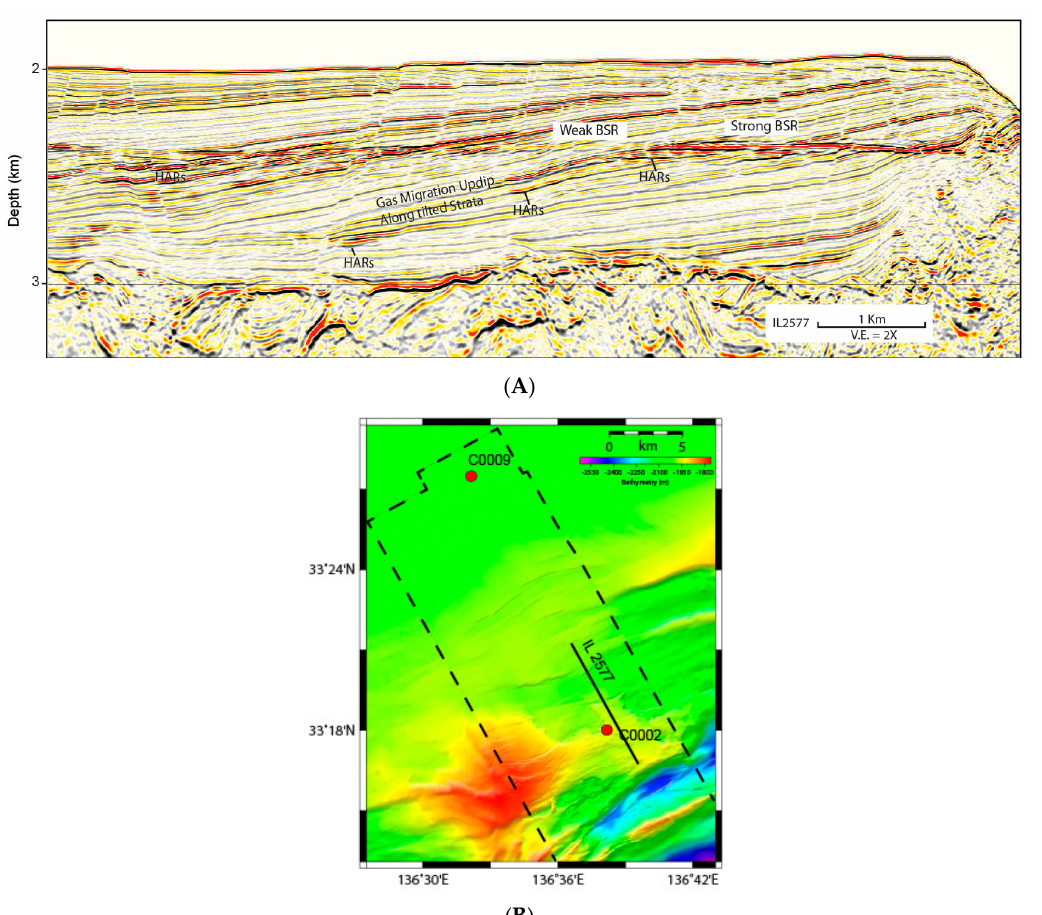
Figure 3. ( A ) Bathymetric map of the study zone for reference. ( B ) BSR depth map in meters below sea-level. Red triangles represent drill Sites C0009 and C0002. The BSR generally mirrors the seafloor behavior and is continuous across the large normal faults. Blank zones in the BSR map within the survey regions are areas where BSRs were not imaged in the seismic data.